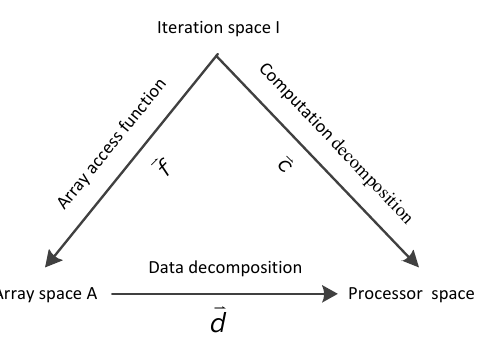
Figure 5. The mapping relationship through three